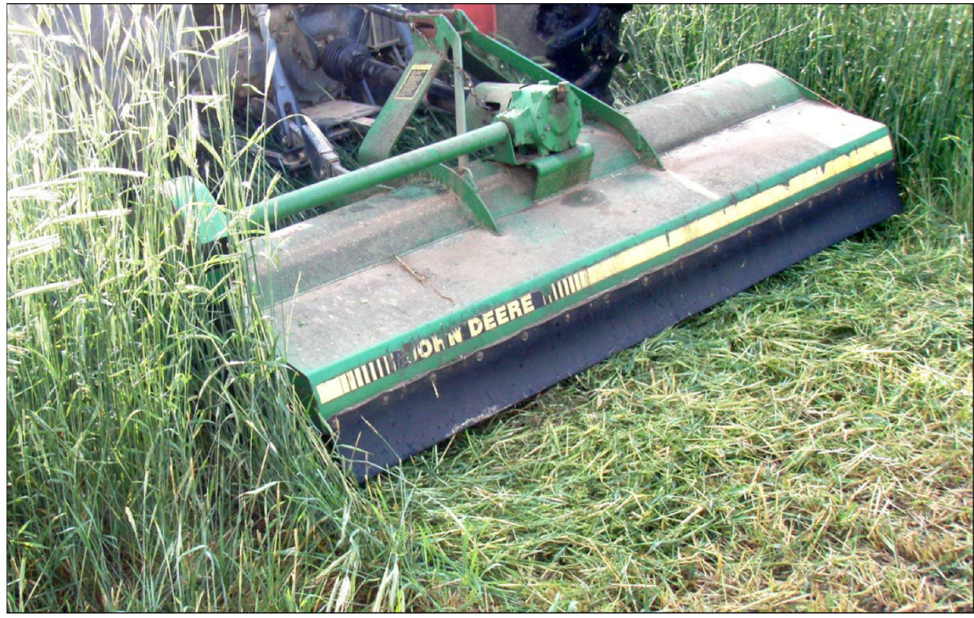
Figure 5. Flail mower (John Deere, Moline, Ill.) in cereal rye.